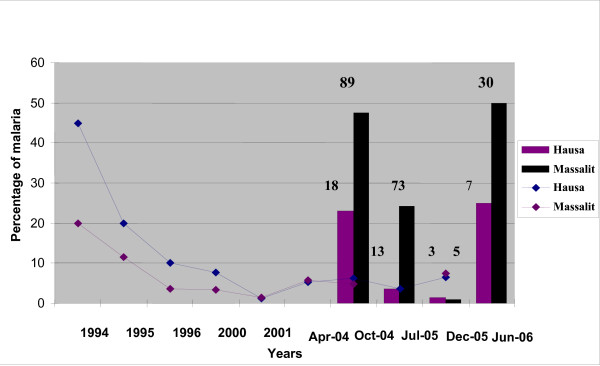
Prevalence of malaria in the two villages, 1994-2006. Lines define the prevalence during eight surveys from 1994 to 2005. Bars show the proportion of clinical malaria cases to the total febrile episodes as percentage in the two populations during follow up intervals in 2004, 2005 and 2006. Numbers on top of the bars indicate the actual number of cases of clinical malaria.